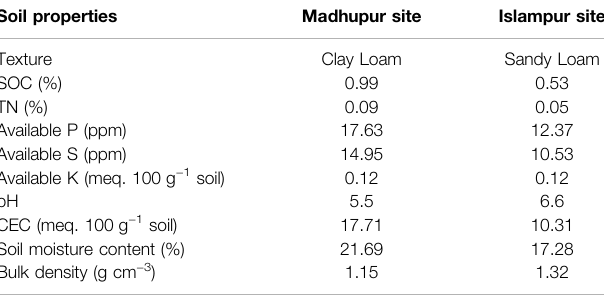
TABLE 1 | Initial physical and chemical parameters of soil at Madhupur and Islampur site. Soil